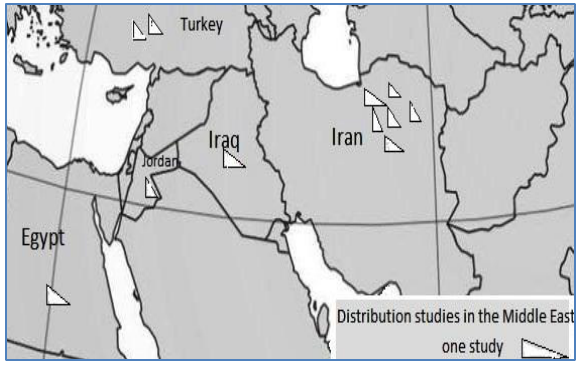
Figure, 1: Distribution studies in the Middle